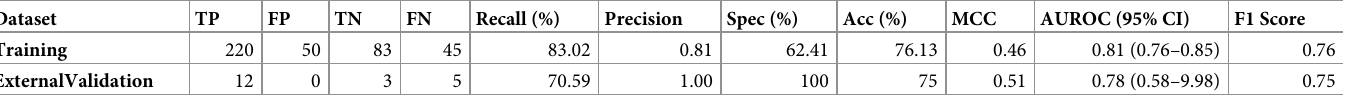
Table 4. The performance measures of the SVC based model, developed using 18-features set on training (TCGA dataset) and external validation (GSE48953) dataset.